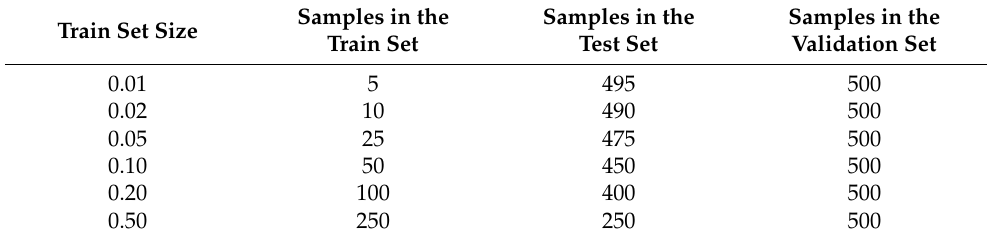
Table 3. Number of samples per set, all randomized from 10 000 spectra at each iteration. Train Set